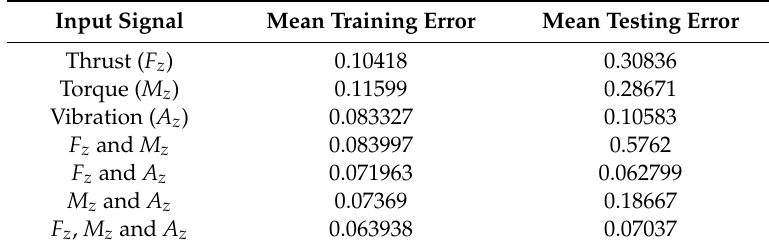
Table 2. Adaptive neuro fuzzy inference system (ANFIS) performance for di ff erent combinations of time domain